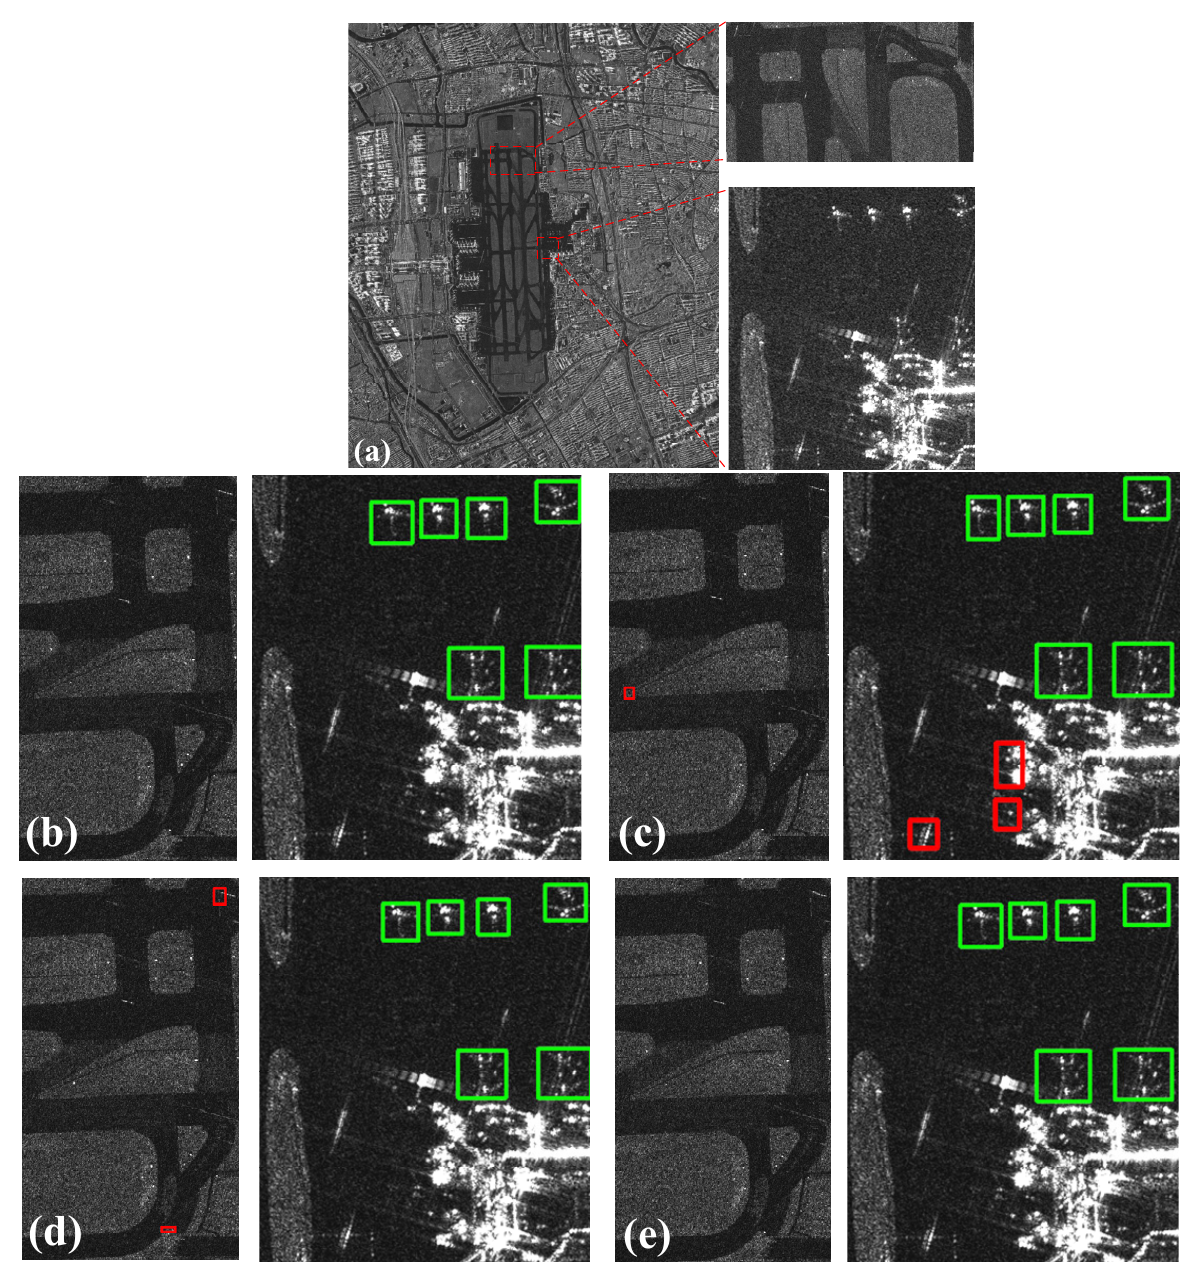
Figure 11. The experiment result for Airport Ⅰ . ( a ) SAR image of Airport Ⅰ from Gaofen-3. ( b ) The ground truth of the airport. ( c )–( e ) the aircraft detection results of ( a ) by EfficientDet, YOLOv4, and EWFAN. The green box, the red box, and the yellow box represent the correctly detected aircrafts, the false alarms, and the missed alarms respectively.